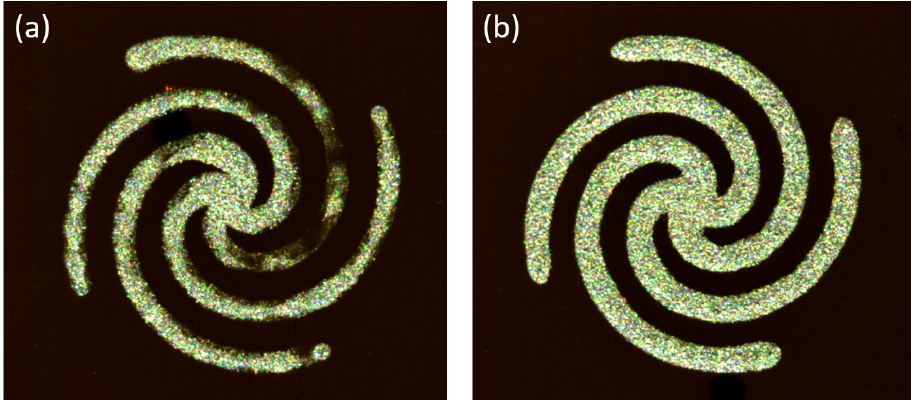
Figure A2. ( a ) Printed spiral image with major print defects including tapered arms, large portions of missing ink, and varied arm width. ( b ) Printed spiral image with near ideal geometry.